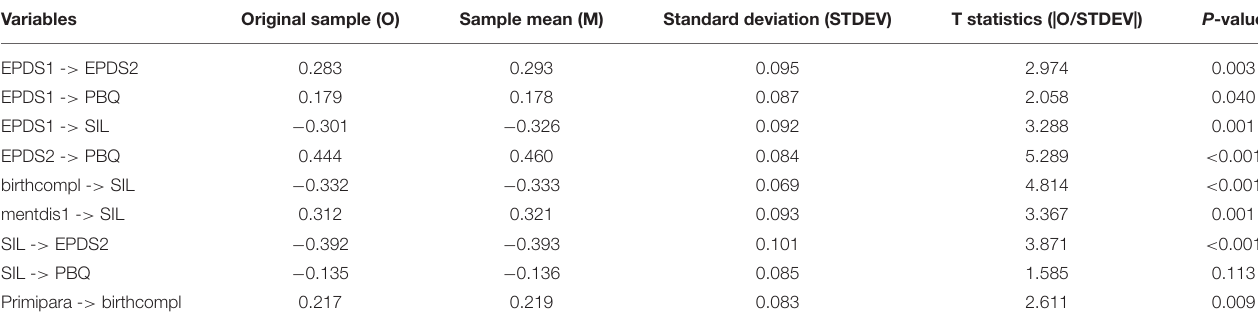
TABLE 3 | Structural model with complete cases ( n = 131).